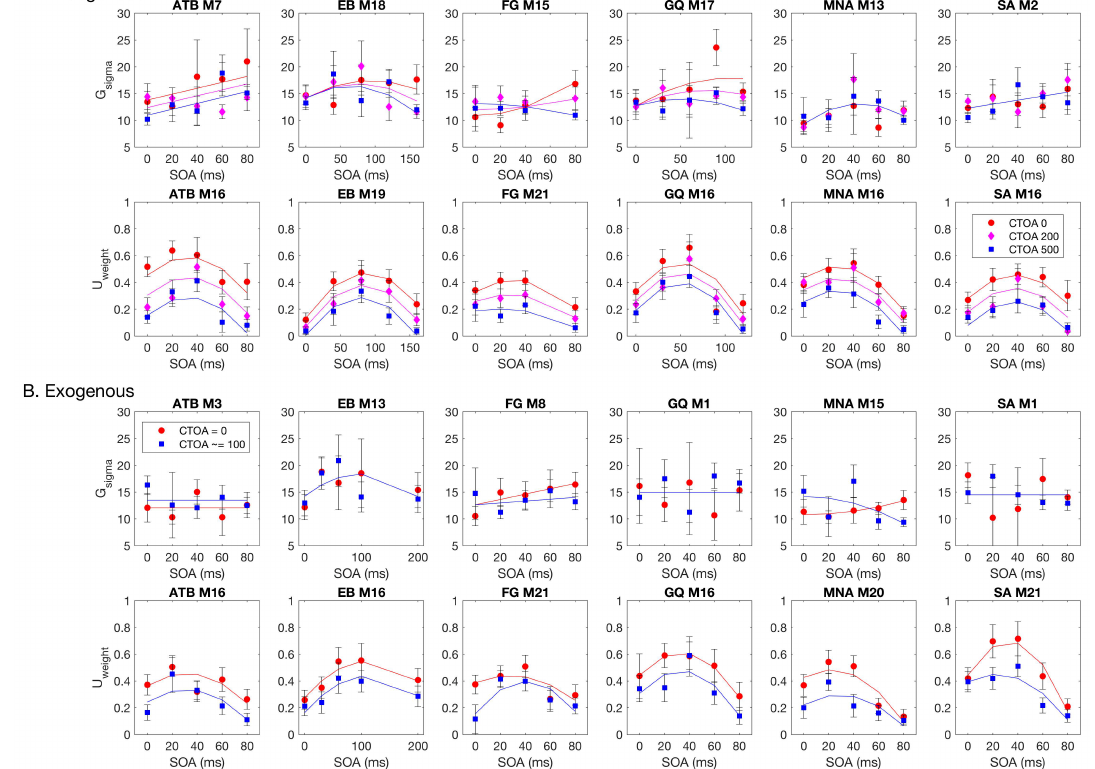
Figure 6. Pairwise BMC differences between the statistical models tested. A square with coordinates (x,y) on each plot represents the BMC difference between model y and x. In order to have the same color notation (i.e., cooler colors mean better model performance and hotter colors mean worse model performance) as in Figure 4, we flipped the sign of the BMC differences. For both types of attention and for all observers, the GU model performs best in explaining the distribution of signed response errors, as indicated by the darkest blue color at the (G, GU) coordinate in all